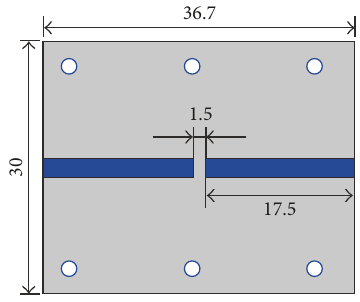
Figure 6: The structure for measuring SMD component.